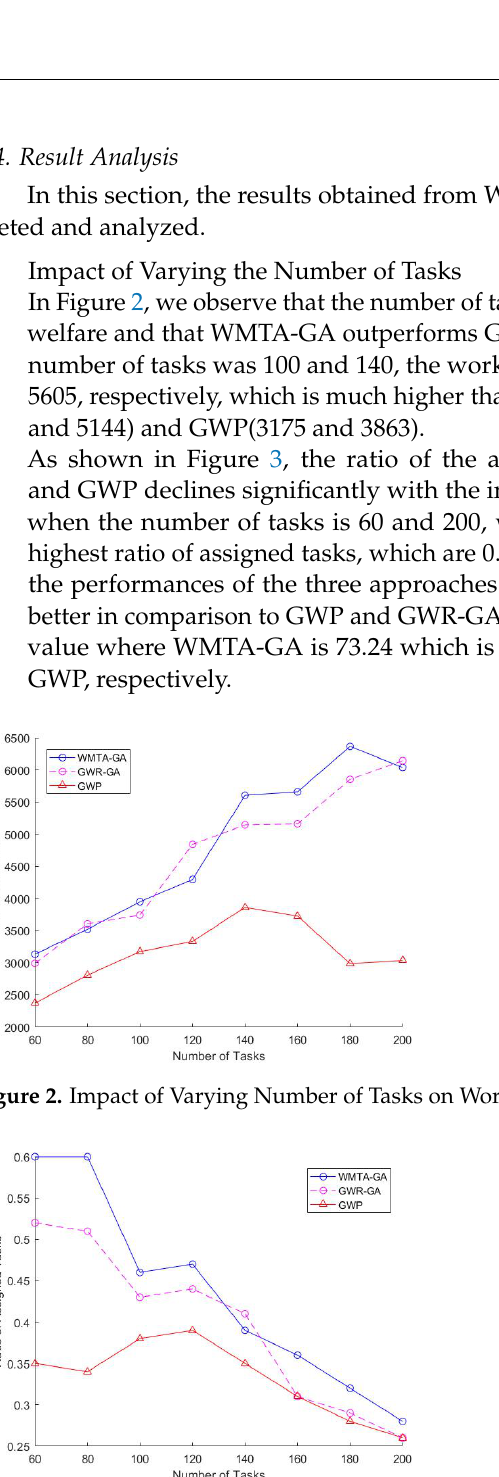
Figure 3. Impact of Varying Number of Tasks on Ratio of Assigned Tasks. Table 2. Average performance w.r.t Varying Number of